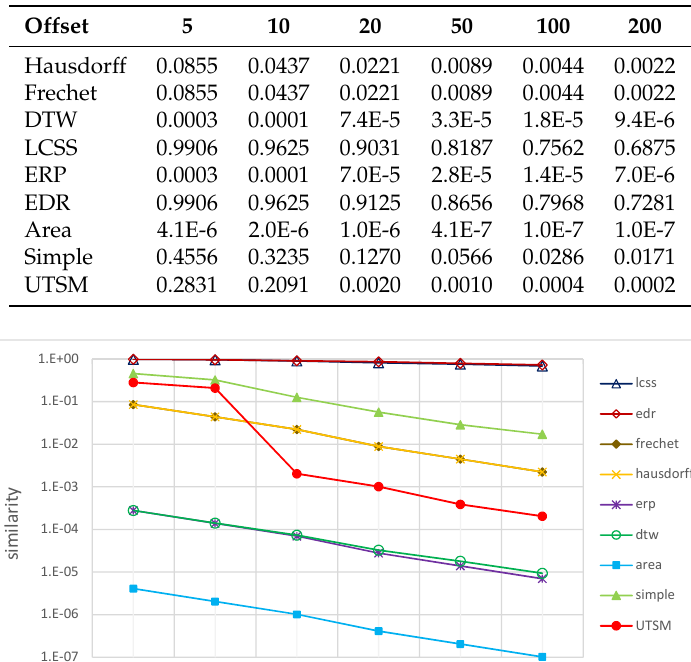
Table 2. Similarity value of different measures for trajectories with different offsets.